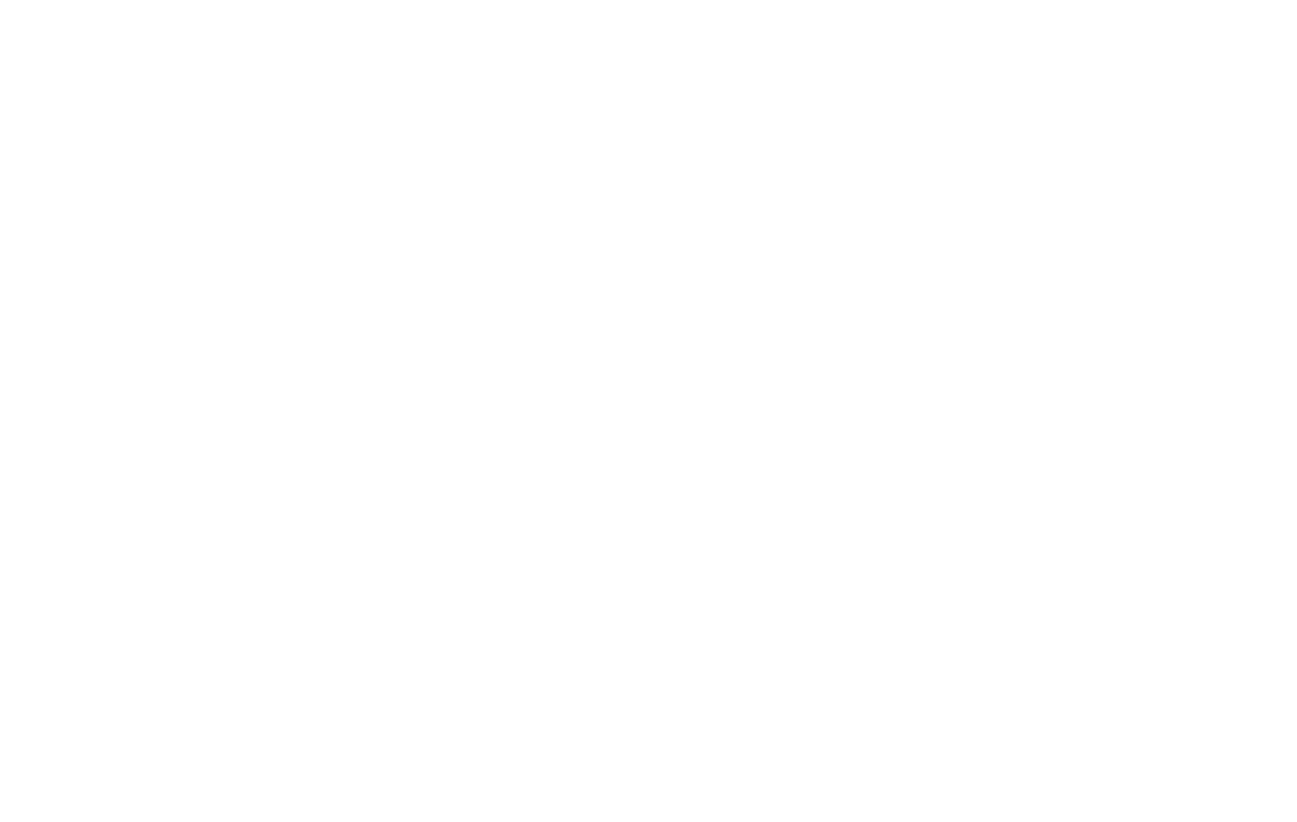
Frontiers in Microbiology |Terrestrial Microbiology March 2012 |Volume 3 | Article 77 |